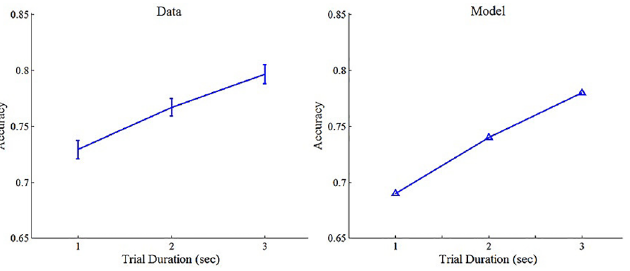
Fig 9. Observed (left panel) and predicted (right panel) accuracy per trial duration in Exp.1. Error bars denote 1 within-participant S.E.M [39]. Accuracy was calculated based on actual samples; the model's predictions were generated using the best-fitting parameters that were obtained by fitting the DLCA to the 3-sec